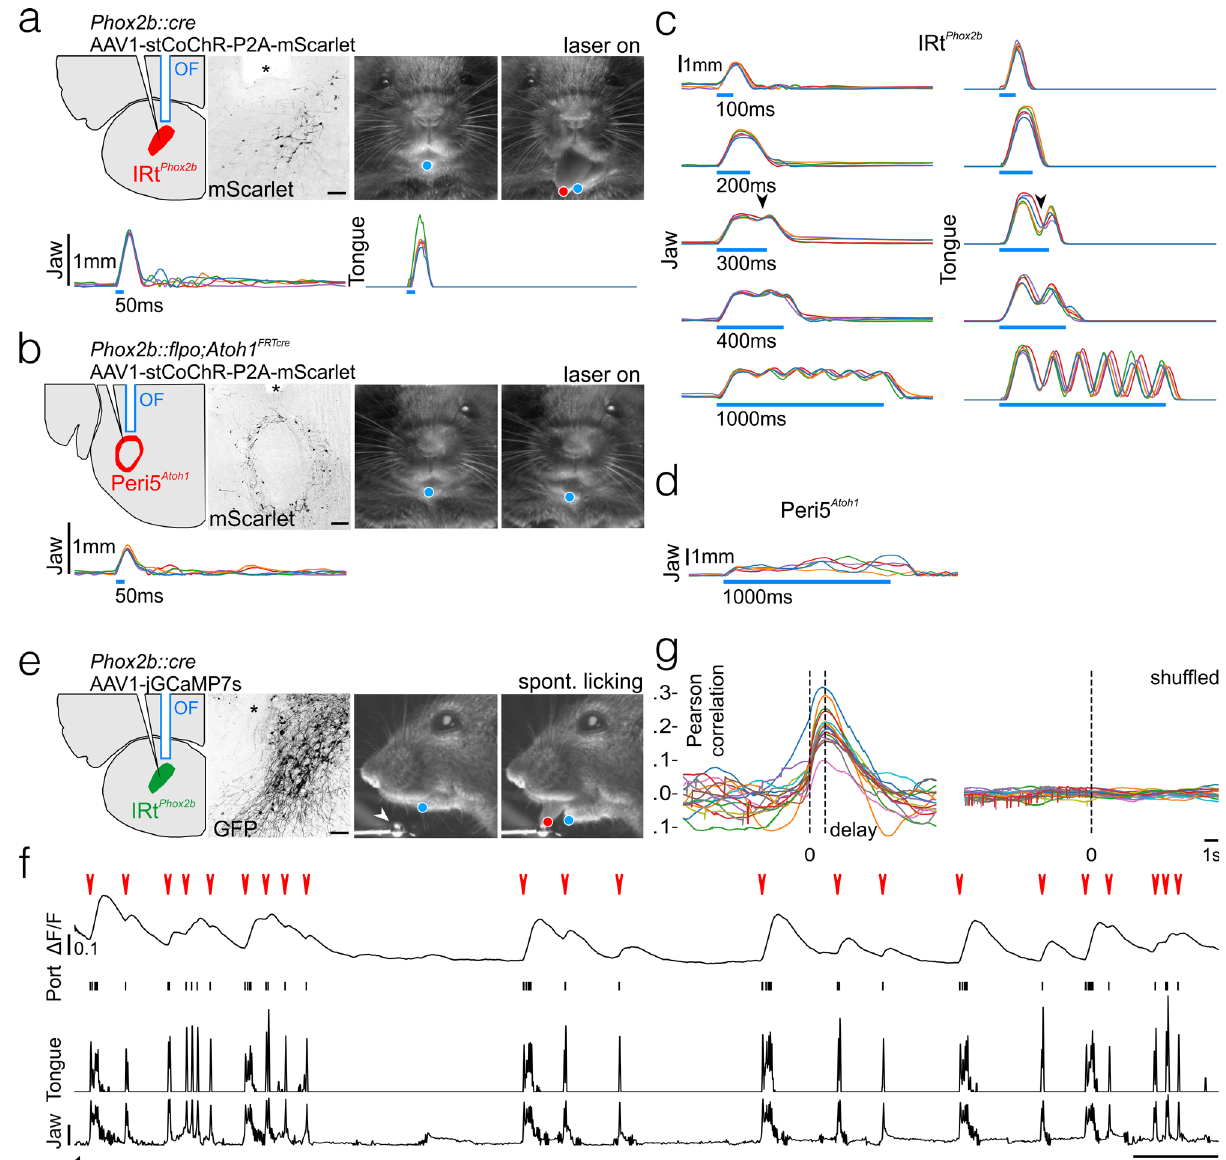
Fig. 4 Orofacial movements triggered by IRt Phox2b and Peri5 Atoh1 and activity of IRt Phox2b during voluntary licking. a (Upper left) Schematic of the viral injection and fi ber-optic implantation for stimulation of IRt Phox2b , and transverse section through the hindbrain showing transduced IRt Phox2b neurons and position of optical fi ber (OF, asterisk); scale bar 100 μ m. (Upper right) Example frames of the mouse face before and during stimulation including DeepLabCut tracked position of the jaw (blue) and tongue (red). (Lower) Individual traces of tracked jaw and tongue position on the Y-axis upon 50 ms stimulation ( fi ve trials). b (Upper left) Schematic of the viral injection and fi ber-optic implantation for stimulation of Peri5 Atoh1 and transverse section through the hindbrain showing transduced Peri5 Atoh1 neurons and position of optical fi ber (asterisk); scale bar 200 μ m. (Upper right) Example frames of the mouse face before and during stimulation including DeepLabCut tracked position of jaw (blue). (Lower) Individual traces ( fi ve trials) of tracked jaw position on the Y-axis upon 50 ms stimulation. c Individual traces ( fi ve trials) of the tracked jaw (left) and tongue (right) position on the Y-axis upon stimulation of IRt Phox2b of increasing length. A repetitive movement is triggered by stimulation beyond 300 ms (arrowhead). d Individual traces ( fi ve trials) of tracked jaw position on the Y-axis upon a 1000ms stimulation of Peri5 Atoh1 . The jaw remains open and quivers non-rhythmically during the stimulus. e (Left) Schematic of viral injection and optical fi ber implantation for observation of IRt Phox2b activity, and transverse section through the hindbrain showing transduced IRt Phox2b neurons and position of optical fi ber (asterisk); scale bar 100 μ m. (Right) Example frames of the mouse face before and during a bout of licking from a lick port (arrowhead), during a photometry recording, including DeepLabCut tracked position of the jaw (blue) and tongue (red). f Example trace of change in bulk fl uorescence of IRt Phox2b during a recording session ( ∼ 2 min) of unitary licking events and licking bouts (red arrowheads), contact events with the lick port, and movements of the tongue and the jaw on the Y-axis. g (left) Superimposed correlation curves between licking activity and calcium activity (each curve corresponding to one of 15 recording sessions, each 1 – 5 min, in one mouse) which peaked at 1.2 s after lick port contact; (right) no peak was observed after shuf fl ing the